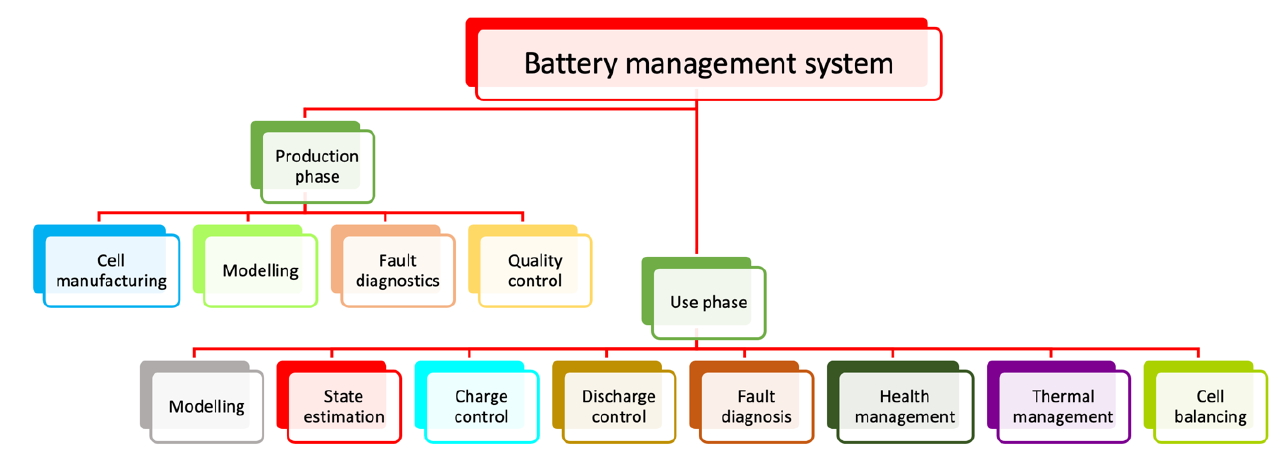
Figure 1. Battery management system (BMS) functional features for battery electric vehicle lithium-ion batteries.